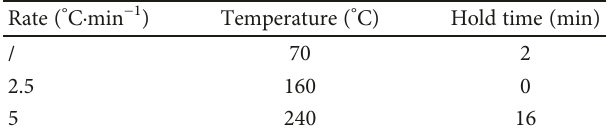
Table 1: Temperature program of column incubator in